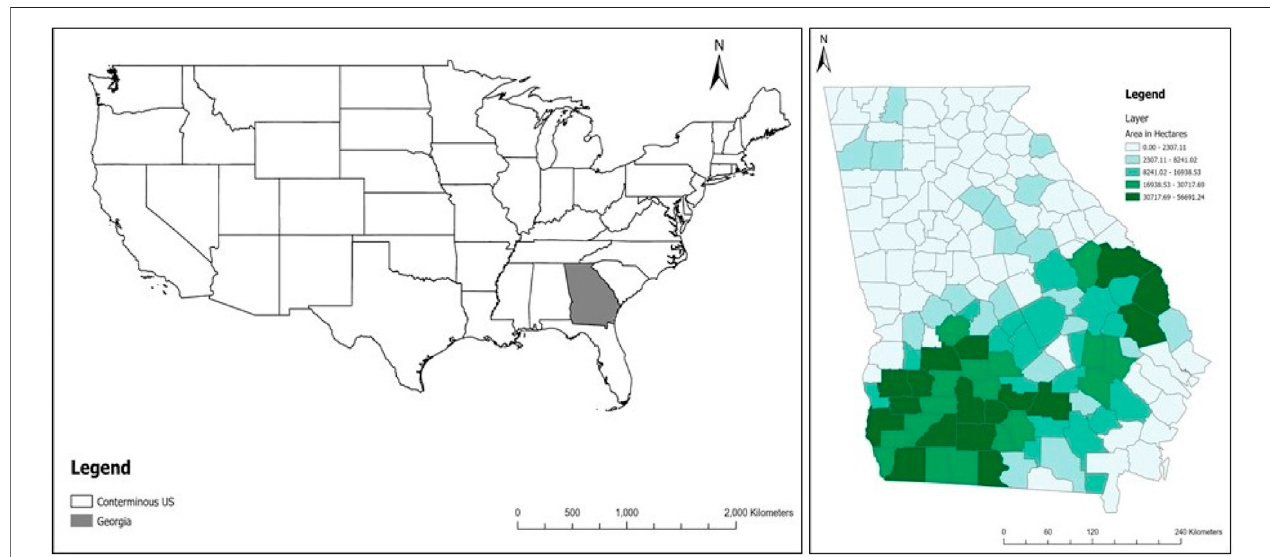
FIGURE 1 | Countywise distribution of agricultural land in Georgia (NASS, 2020).